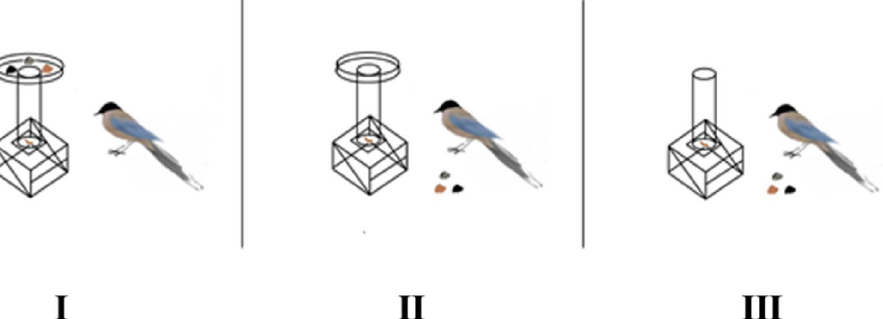
Figure 1. Training device. ( I ) Owing to the stimulation provided by the possibility of obtaining a reward, the Azure-winged magpies used their beak or body to touch the device to make the natural stone in the tray slide into the tube, thereby triggering the mechanism to make the reward fall. If the Azure-winged magpies started to push the stones in the tray into the pipe actively, it will enter stage II. ( II ) After several times, the natural stones were randomly scattered in the cage. If Azure-winged magpies moved the stone onto the tray and repeated stage I or directly put the stone into the tube, it marks the completion of stage I. If not, returning to phase I. ( III ) The tray was removed, and natural stones were randomly selected and scattered in the cage. If Azure-winged magpies directly put the stone into the tube, it marks the completion of stage II. If not, returning to phase II.